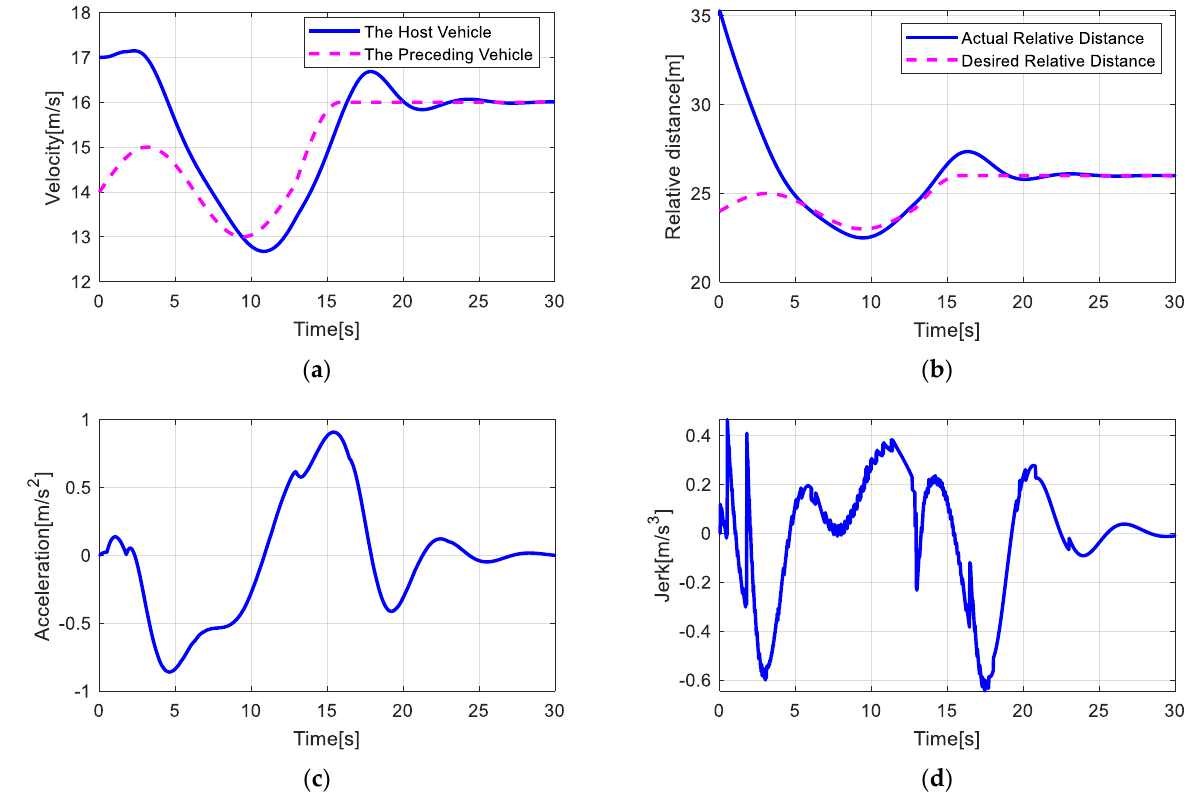
Figure 21 . The simulation results of vehicle following scenarios: ( a ) the velocity of the host vehicle and the preceding vehicle; ( b ) the relative distance between the host vehicle and the preceding vehicle; ( c ) the acceleration of the host vehicle; and ( d ) the jerk of the host vehicle.